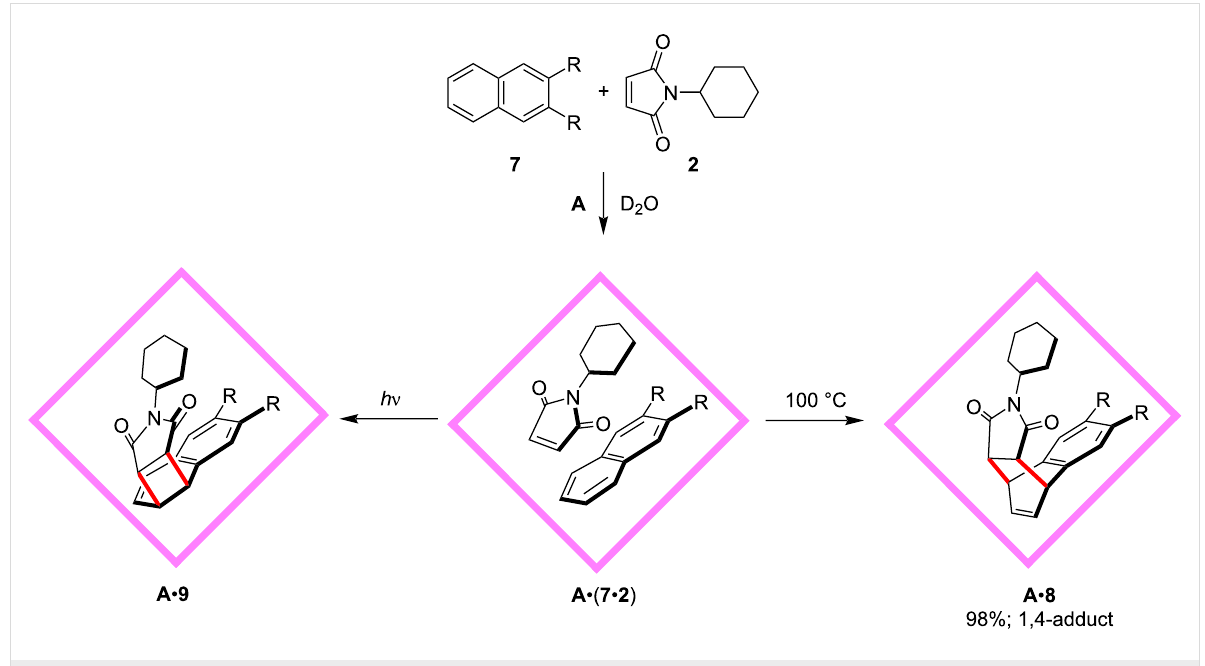
Figure 2: Site-selective Diels–Alder and [2 + 2]-photoaddition reactions between naphthalene and phthalimide mediated by cage host A